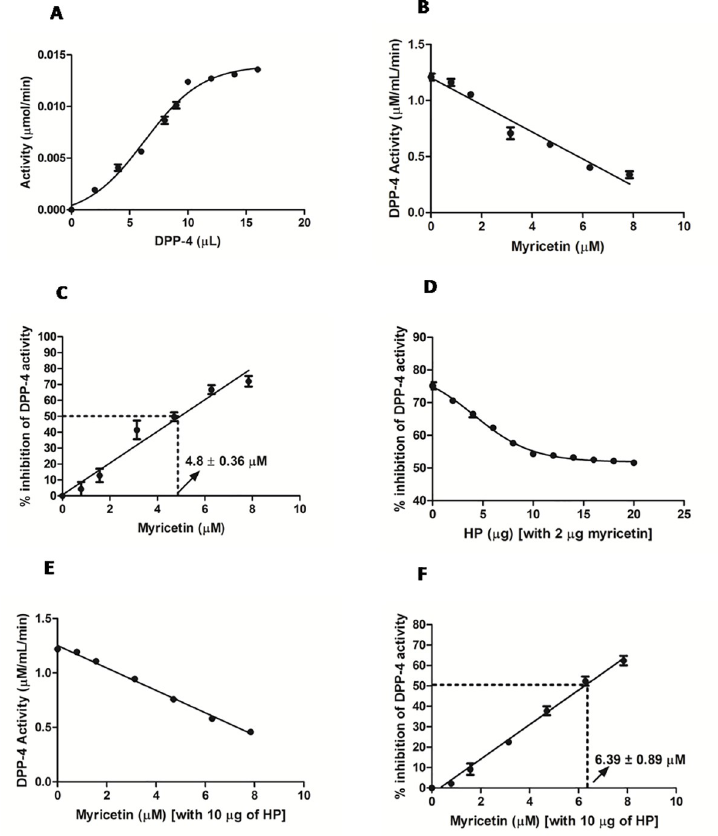
Fig 1. In-vitro effects of myricetin and HP on DPP-4 activity. A. Standard curve for DPP-4 activity. B-C. Inhibition effect of Myr on DPP-4 activity. Myr inhibited DPP-4 activity with an IC 50 value of 4.8 ± 0.36 μ M. D. Inhibitory effect of Myr, in presence of different ratios of HP on DPP-4 activity. The DPP-4 inhibitory activity of Myr was reduced in the presence of HP in the ratio of 1:5. E-F. Effect of HP (10 μ g) on the DPP-4 inhibitory activity of Myr. In the presence of HP, Myr exhibited reduced DPP-4 inhibition activity, and its IC 50 value shifted to 6.39 ± 0.89 μ M. Data are mean of triplicate values.